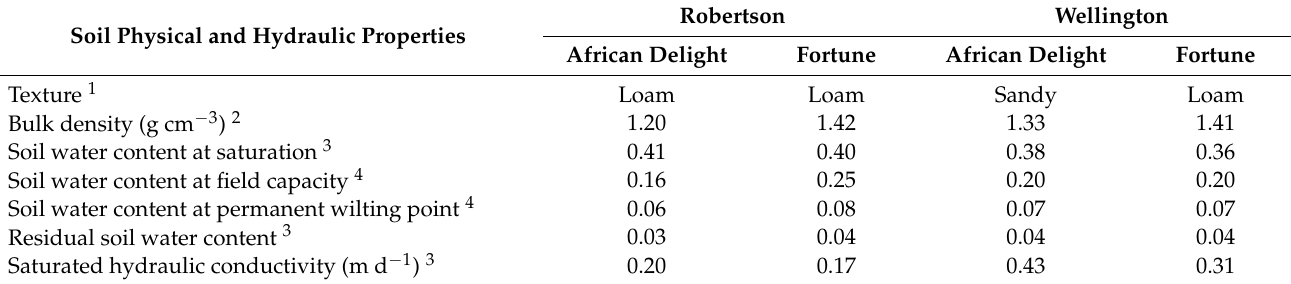
Table 1. Soil physical and hydraulic